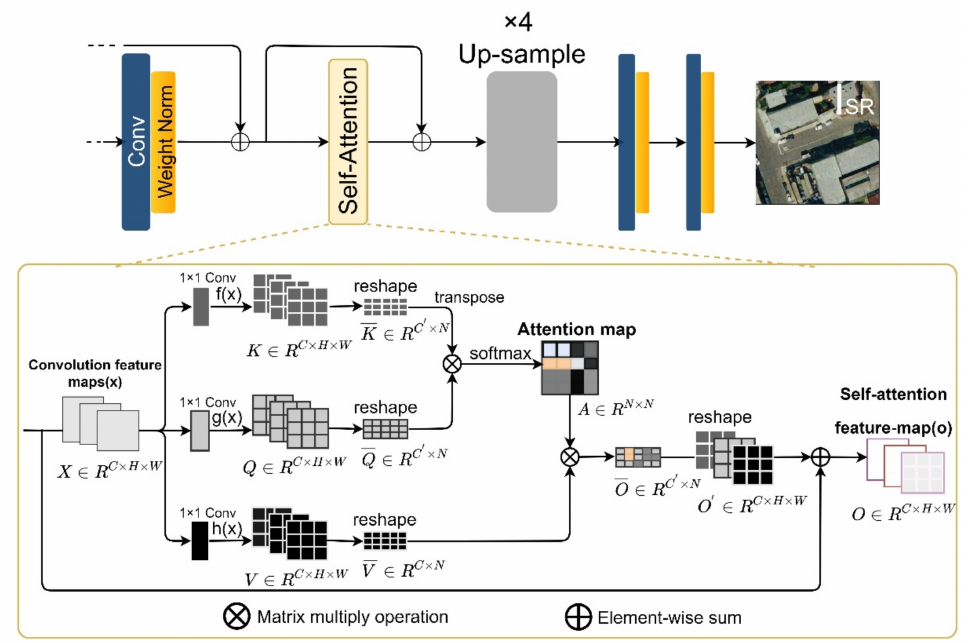
Figure 4. The self-attention mechanism module